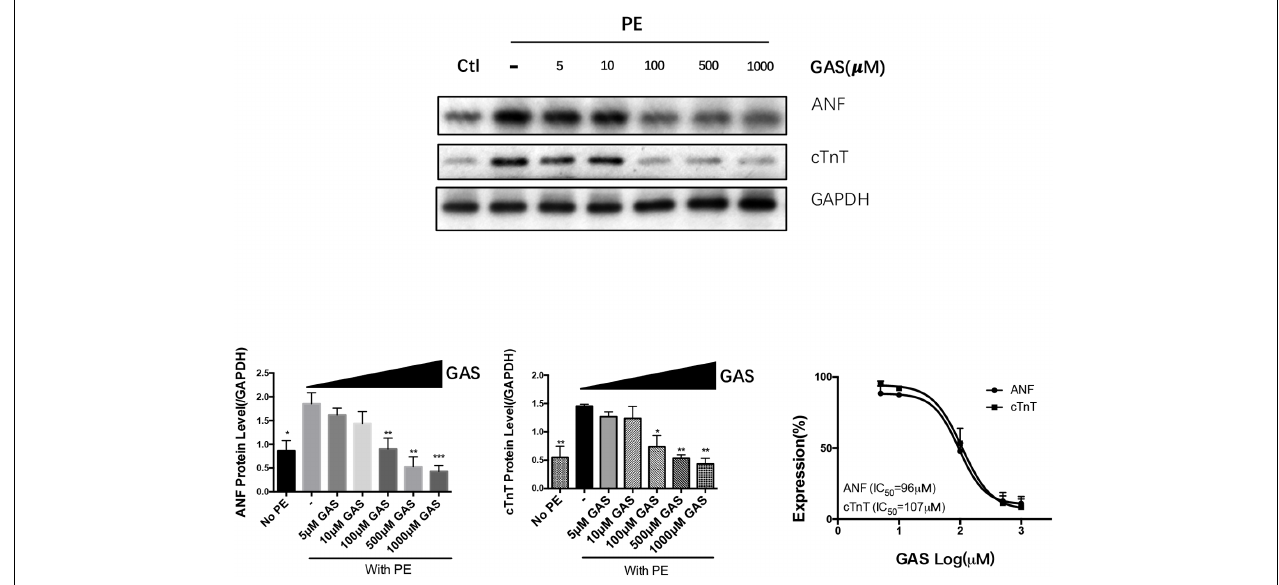
FIGURE 3 | Dose-dependent inhibition of gastrodin on phenylephrine-induced hypertrophy of NRCMs. NRCMs were treated with 50 µ mol/L PE for 48 h to induce hypertrophy. GAS (0–1000 µ mol/L) was applied 12 h before PE. The control group (no PE) did not undergo PE treatment. Effect of gastrodin on the expression of ANF and cTnT was demonstrated. Shown were representative immunoblot images (upper panel) , data summary (lower panels) and determination of IC 50 values (lower right) . The data are expressed as the mean ± SEM ( n = 5). ∗ p < 0.05, ∗∗ p < 0.01, ∗∗∗ p < 0.001.